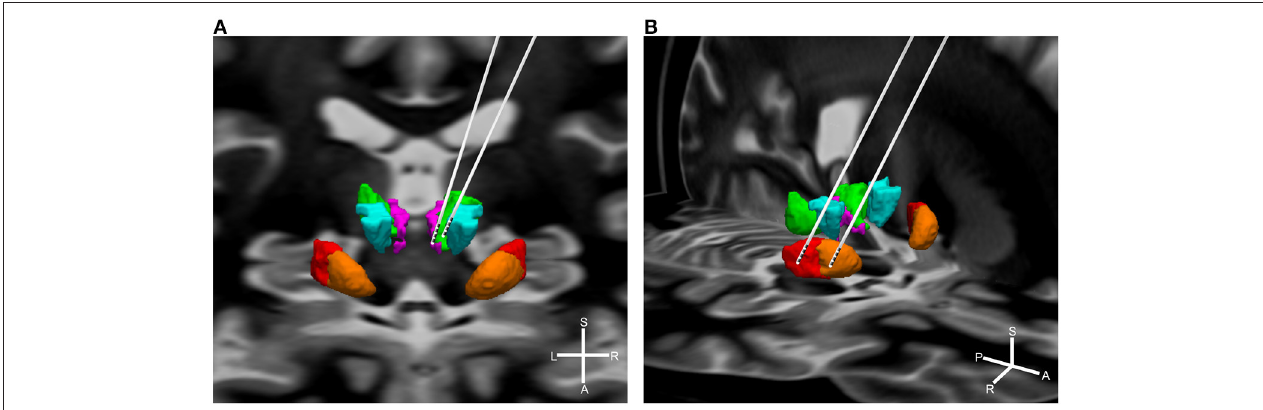
FIGURE 2 | Simplified visualization of DBS electrodes of the different targets. Shown are the target regions: green = CM; purple = Pf; turquoise = Voi; red = pvlGPi; orange = amGPi. For illustration purposes targets are displayed unilateral only. (A) Thalamic targets: left electrode = CM-Pf; right electrode = CM-Voi. Background shows the coronal section of a brain MRI. (B) Pallidal targets: left electrode = pvlGPi; right electrode = amGPi. Background shows the horizontal section of a brain MRI. Graphics were generated using the DISTAL atlas (120) and MNI PD25 atlas (121). S, superior; A, anterior; L, left; R, right.